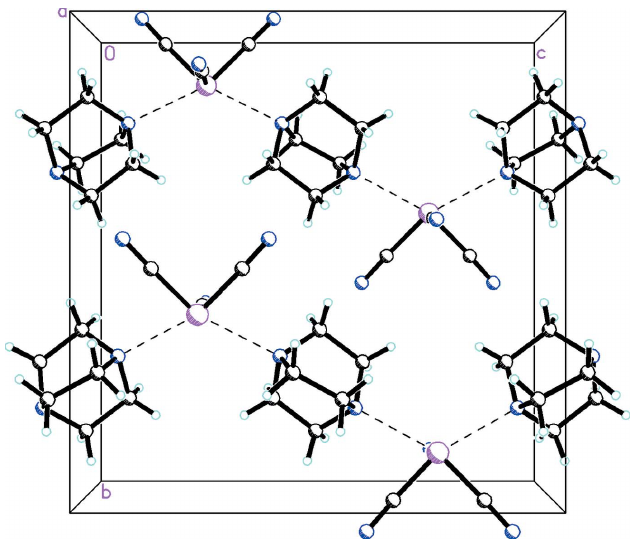
Figure 4 Packing diagram for 1 viewed along the a axis. Interactions with the C 6 H 12 N 2 units are shown as dashed